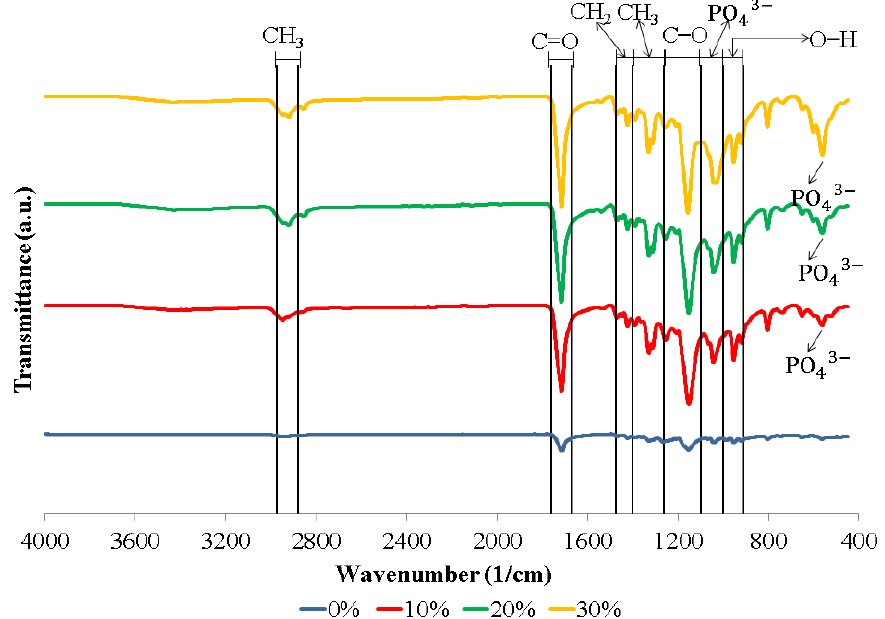
Figure 1. FTIR spectra of biocomposites with various concentrations of nHA.